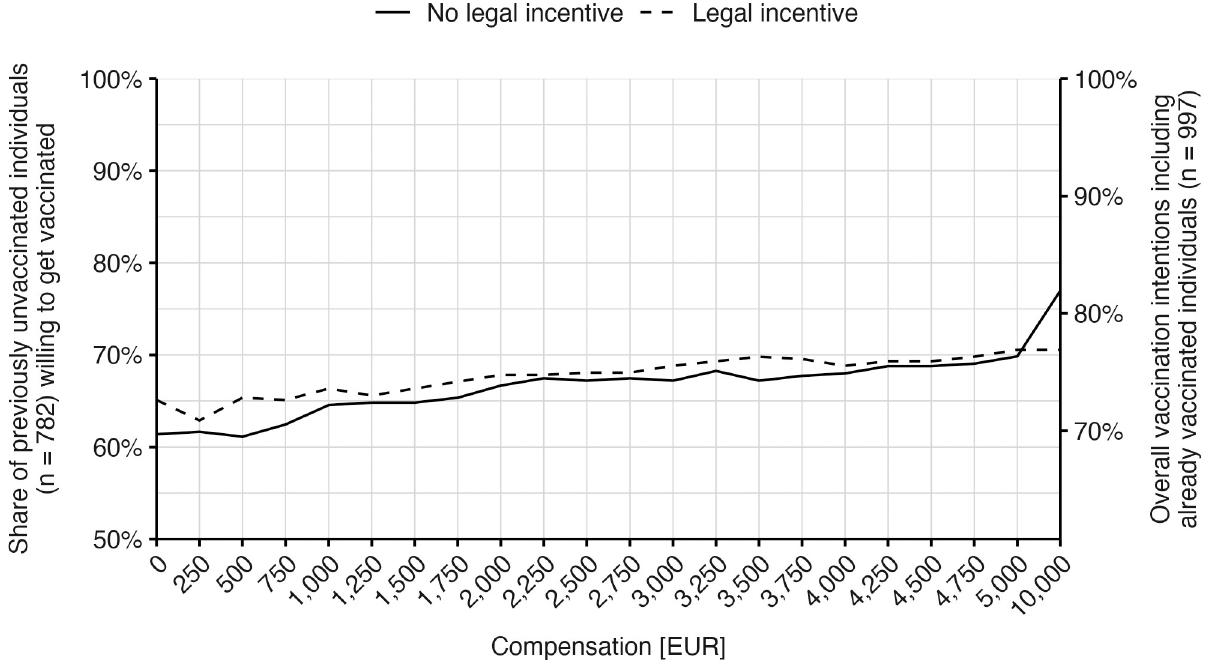
Fig 1. Willingness to get vaccinated by legal and monetary incentives. While legal incentives had virtually no impact on vaccination intentions, monetary incentives of 3,250 EUR and above led to a significant increase of people willing to be vaccinated against COVID-19 (compared to 0 EUR). As a reference, the fraction on the right also includes the n = 215 participants that had already been vaccinated and were not included in the experiment.